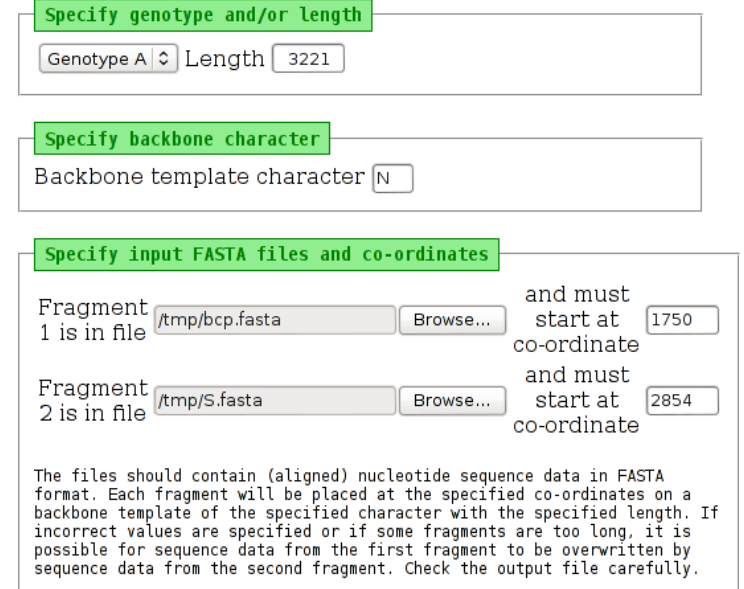
Figure 9. The input page of the “PadSeq Tool”. Selecting a genotype from the list will place a default length into the “Length” field. This value can be edited, if necessary. The backbone character can be changed from the default “N”. Each of the two input files must be specified, along with the starting position (co-ordinate) at which each fragment should be placed. The tool will “wrap” sequence data, which extends beyond the length specified, as may be required when processing HBV sequence